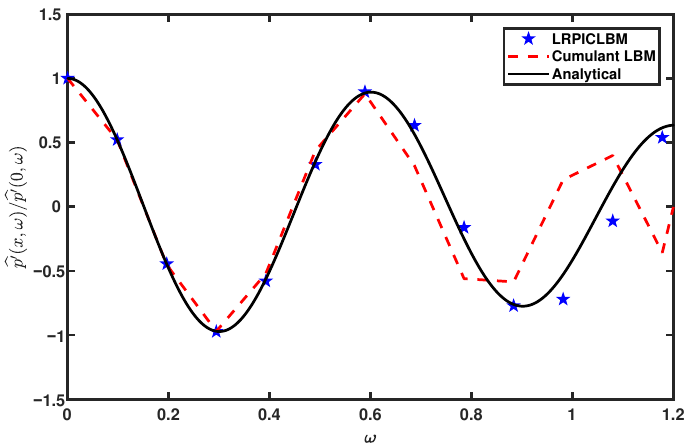
Figure 10. The ratio “ p (cid:48) ( x , ω ) / “ p (cid:48) ( x ,0 ) as a function of angular frequency ( 1 ∆ solution, the cumulant LB and the LRPIC-LB methods.